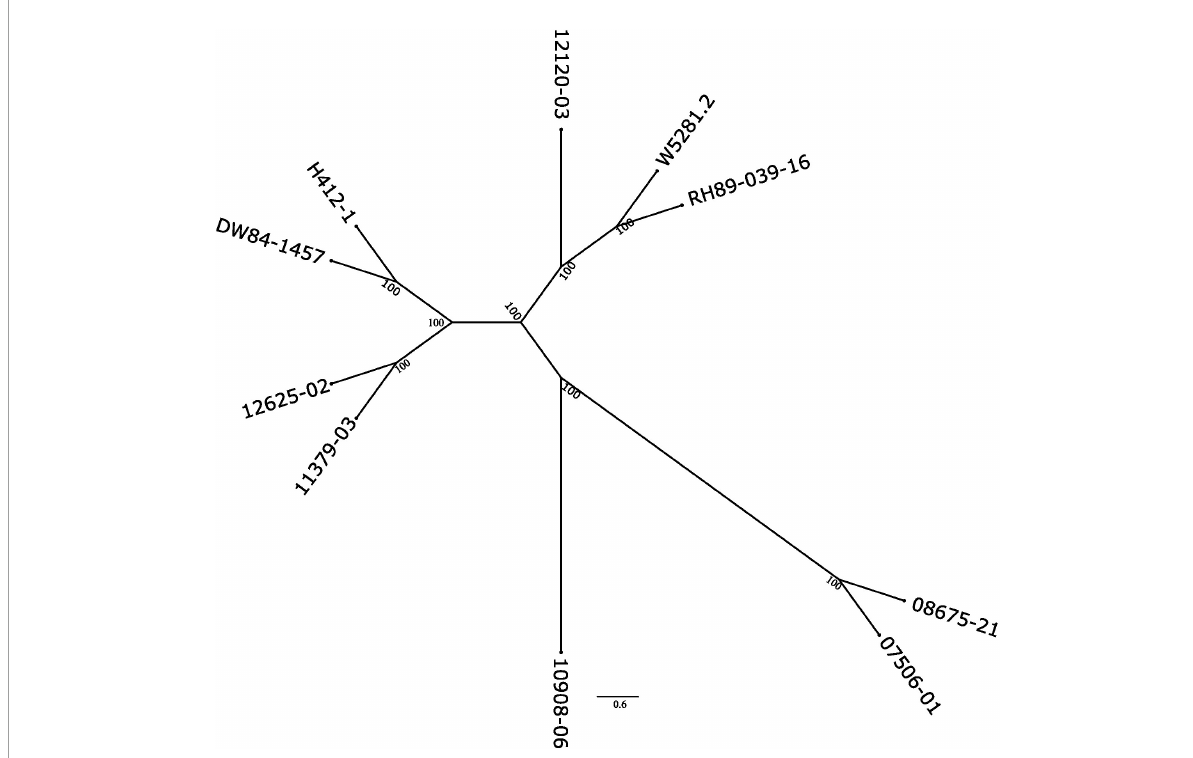
FIGURE3 Phylogenetic tree of the nine diploid clones based on the SNP analysis using the DMv6.1 as a reference.